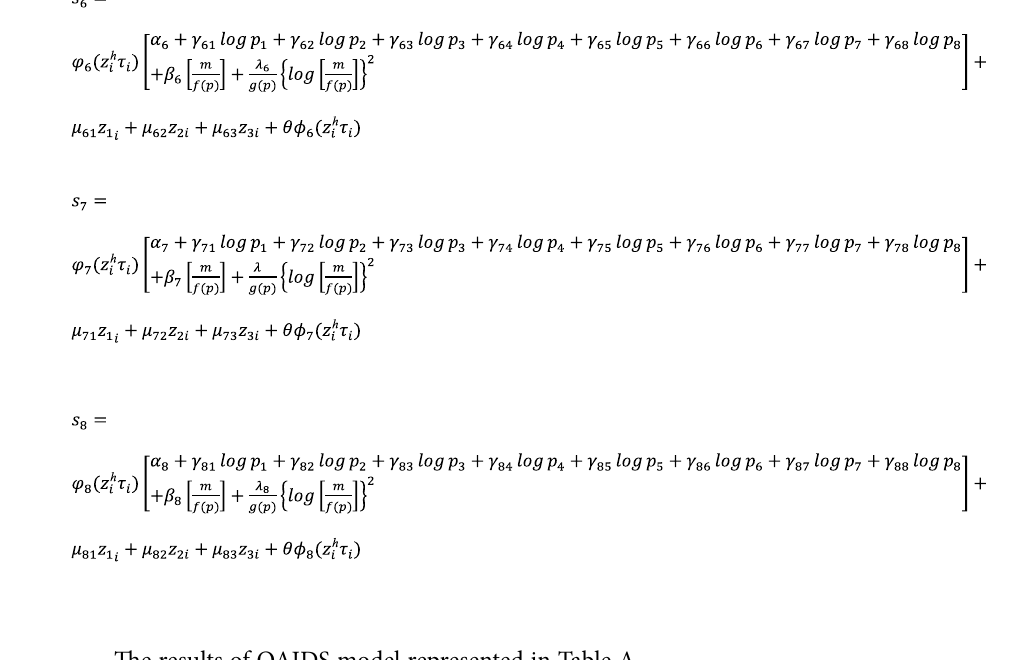
The results of QAIDS model represented in Table A. Table A. Estimated parameters for the QAIDS